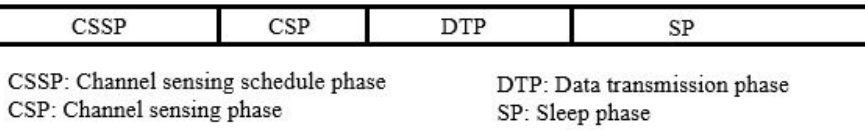
Figure 5. Superframe structure of the cluster-based energy-efficient Figure 5 . Superframe structure of the cluster-based energy-efficient MAC.